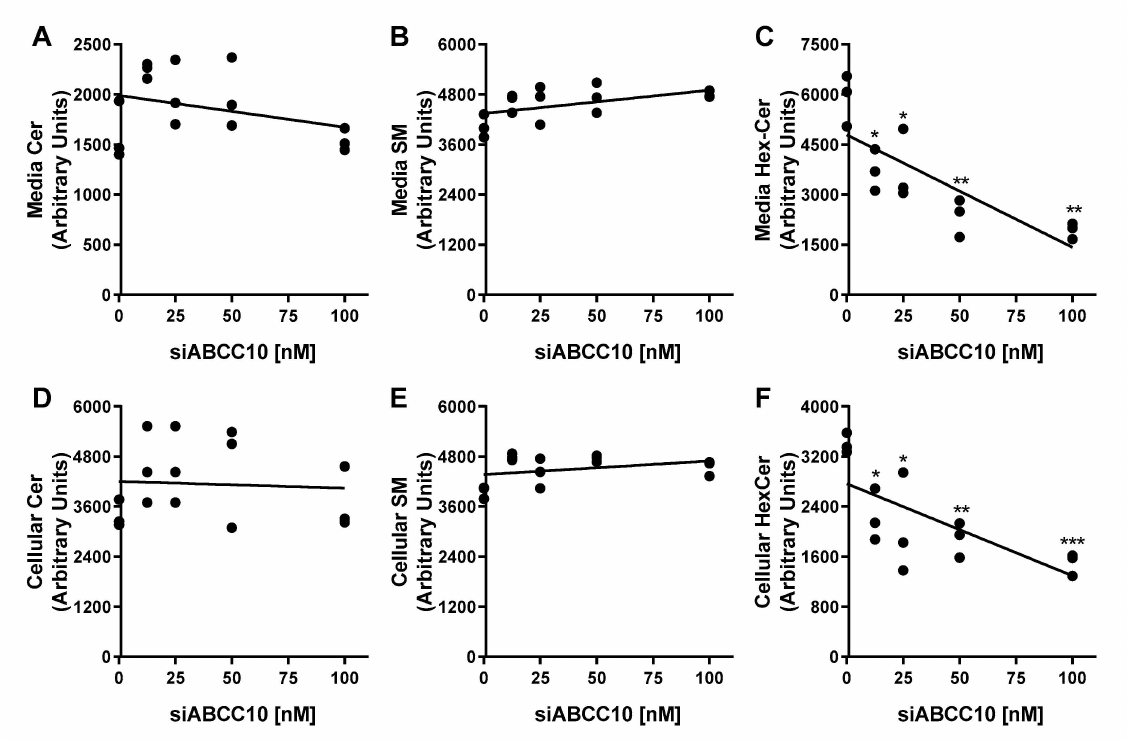
Figure 3. Dose response effect of siABCC10 on HexCer efflux and synthesis. Huh-7 cells were transfected with 12.5, 25, 50, and 100 nM of either siCTRL or siABCC10 in triplicate for 72 h. Cells were used to study HexCer efflux and synthesis as described in Figure 2. Lipids in the media ( A – C ) and cells ( D – F ) were extracted, separated on TLC and fluorescence in Cer, HexCer and SM bands were quantified using Image J. Values are replicates. * p < 0.05, ** p < 0.01 and *** p < 0.001 compared with siCTRL-HDL treated